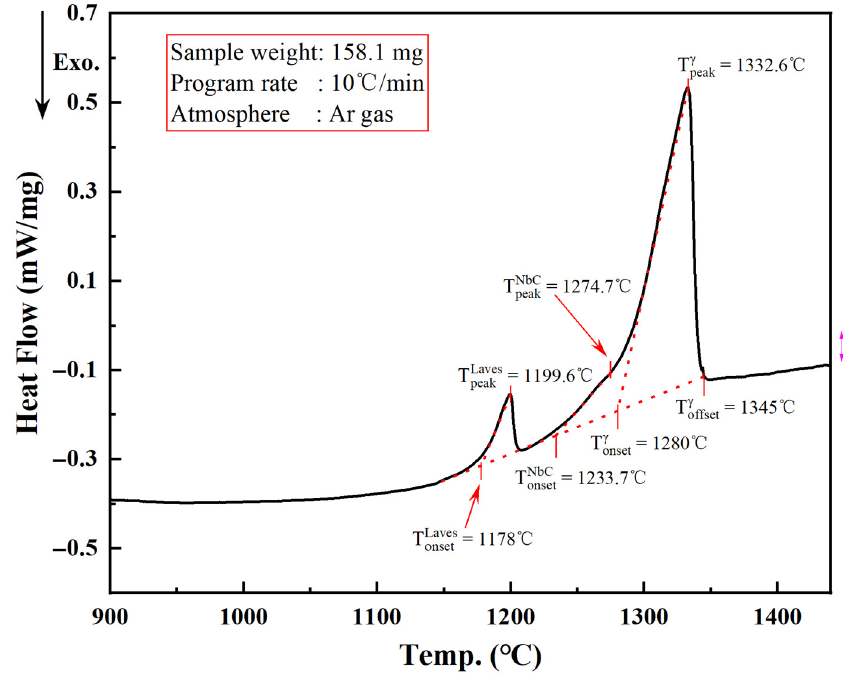
Figure 7. Thermal analysis curve of as-cast GH4169 DSC.